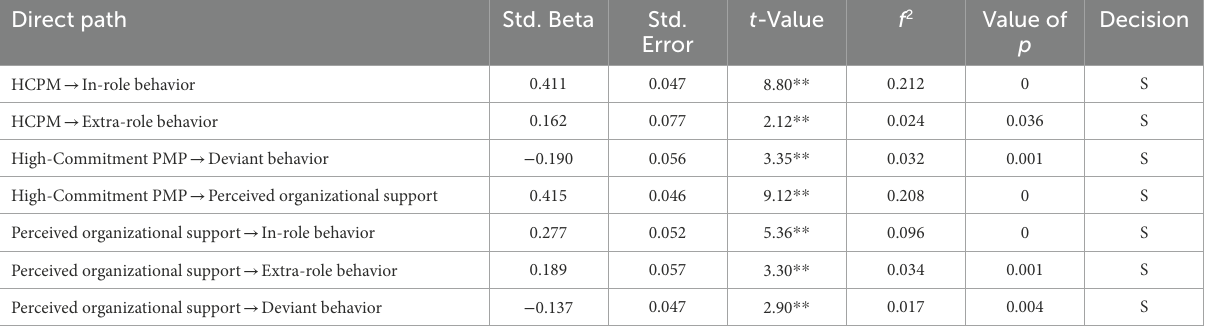
TABLE 5 Structural model direct